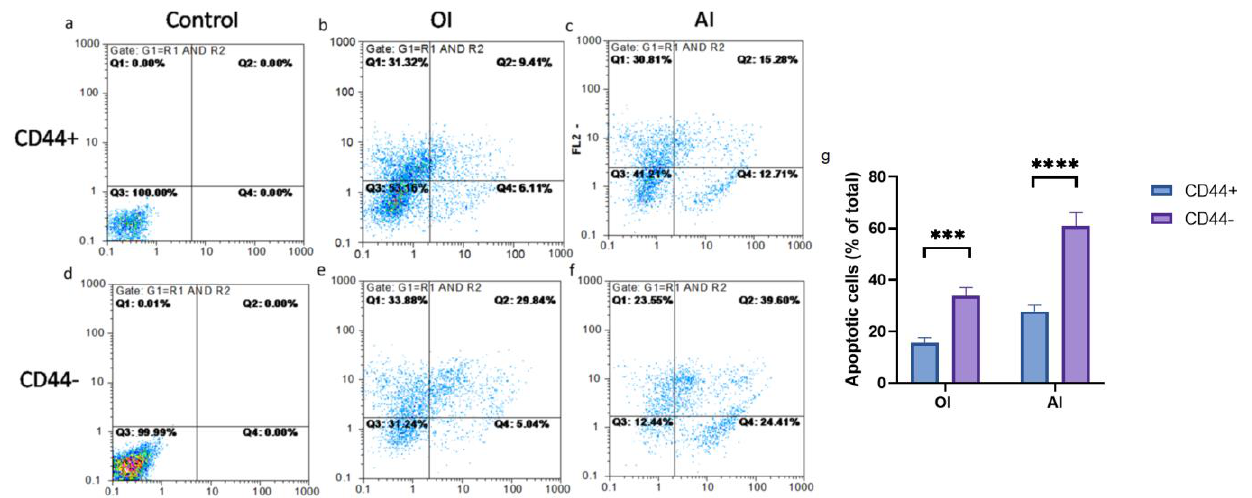
Figure 12. The effects of induction media on CD44 + and CD44 − cell viability. Annexin V apoptotic assay of un-induced CD44 + ( a ) and CD44 − cells ( d ); osteo-differentiated CD44 + ( b ) and CD44 − cells ( e ); adipo-differentiated CD44 + ( c ) and CD44 − cells ( f ); apoptotic cells (% of total cell number) upon osteo-induction (OI) and adipo-induction (AI) ( g ). Control cells cultured in a complete growth medium, CD44 + — CD44-positive cells, CD44 − — CD44-negative cells, *** p ≤ 0 .001, and **** p ≤ 0.0001.